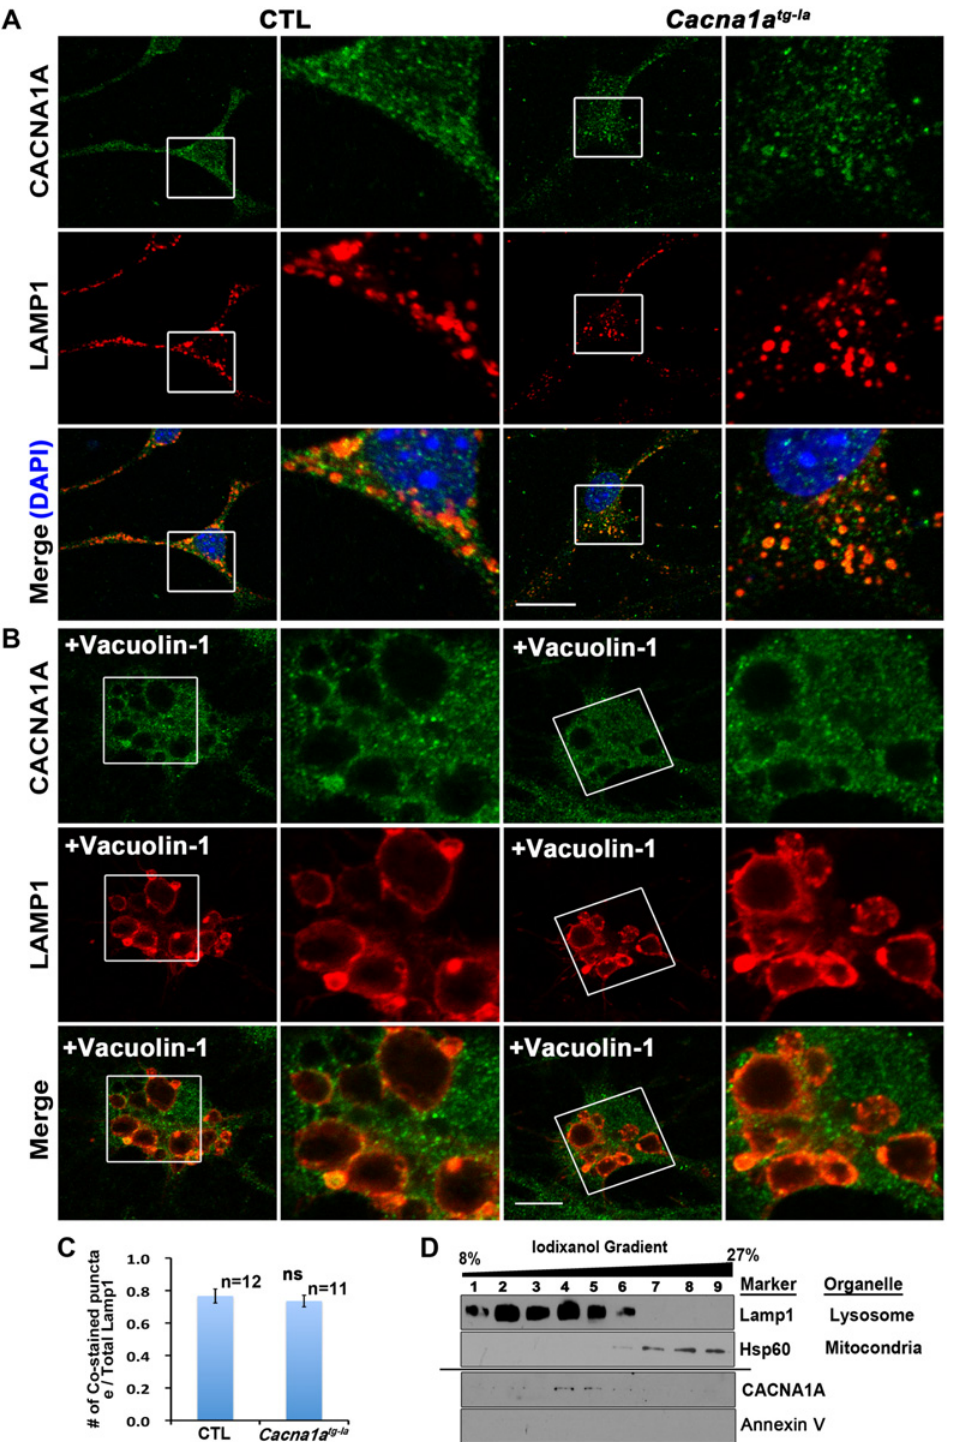
Fig 5. CACNA1A localizes to the lysosomes. A. CACNA1A co-localizes with LAMP1 in primary cerebellar cultures of both CTL and Cacna1a tg-la mutants. Scale bars, 20 μ m. B. CACNA1A is present as punctae on the Vacuolin-1 enlarged LAMP1 positive lysosomes in primary cerebellar cultures of both CTL